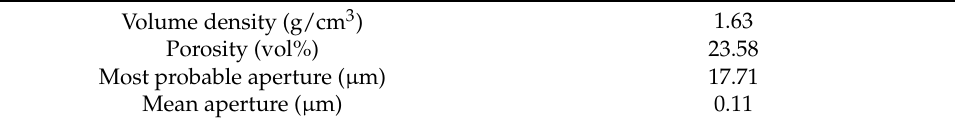
Table 1. Properties of the C/C composites.